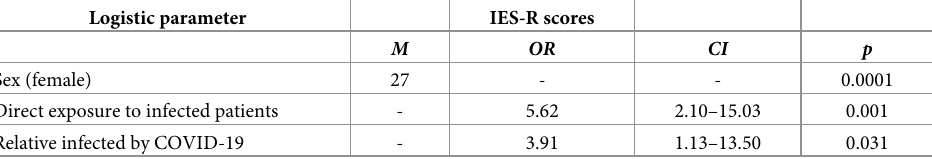
Table 4. Results of multivariate logistic regression of factors associated with increased IES-R scores. Logistic parameter IES-R scores M OR CI p Sex (female)